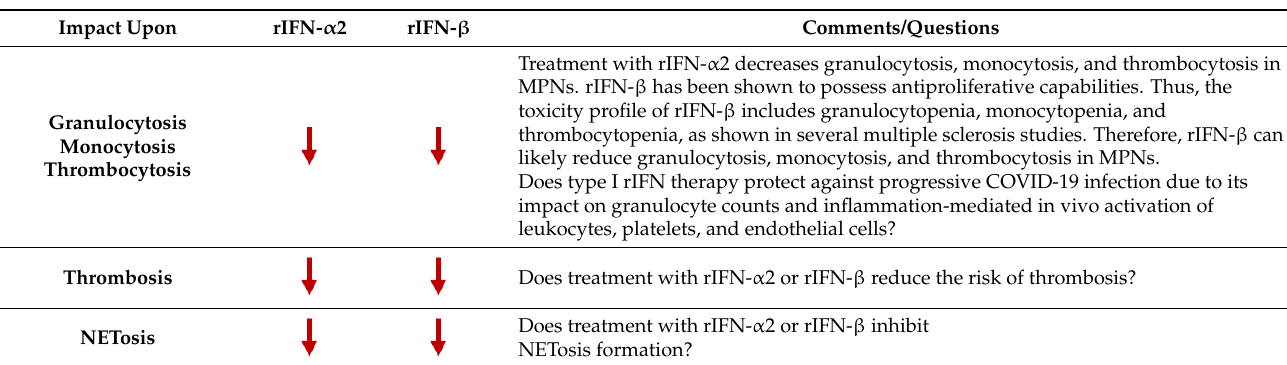
Table 1. Some key questions with regard to the impact of rIFN- α2 and rIFN - β on clinical, biochem- ical, and immunological markers in MPNs.